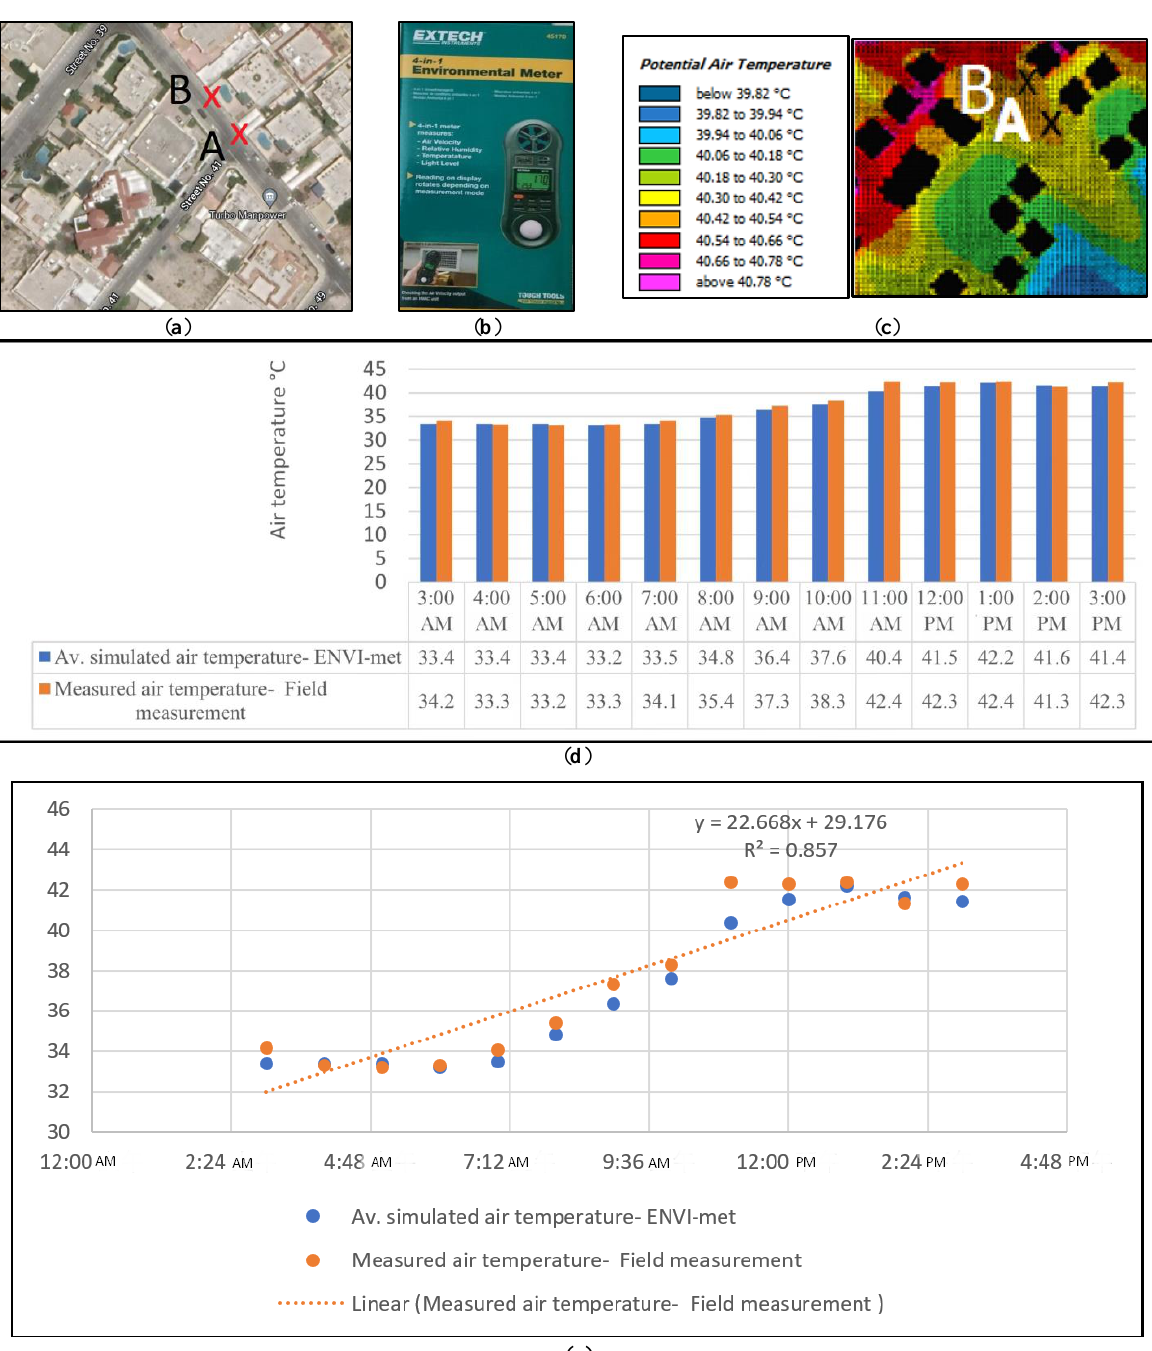
Figure 6. Validation of the results of the software. ( a ) The chosen points for software validation. ( b ) Extech 45,170 m [56]. ( c ) The chosen points in the ENVI-met simulation. ( d ) Graph for both air temperatures: simulated by ENVI-met and measured by Extech 45,170. ( e ) Scatterplot for average measured and simulated data for the validation.